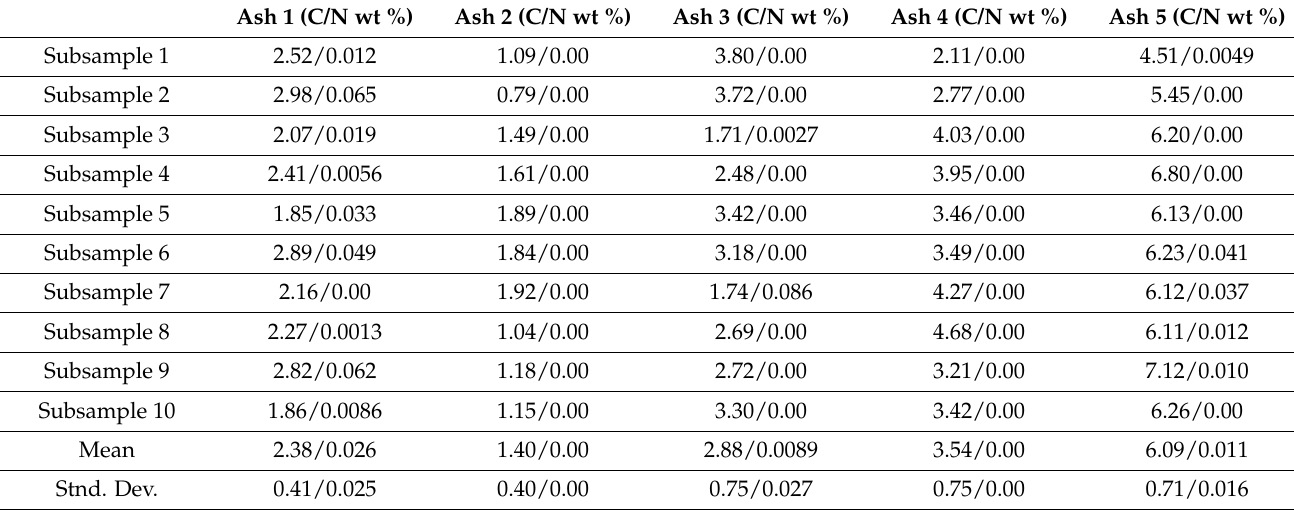
Table 1. Weight % (wt %) of carbon and nitrogen (represented below as C/N) for 10 separate CN analyzer measurements of ash from sites Ash 1–5, along with the means and standard deviations. The detection limit for C was 0.08 mg, which corresponded to a weight % of 0.79. The detection limit for N was 0.1 µ g, which corresponded to a weight % of 0.0013. Nitrogen measurements listed as 0.00 were below the detection limit.